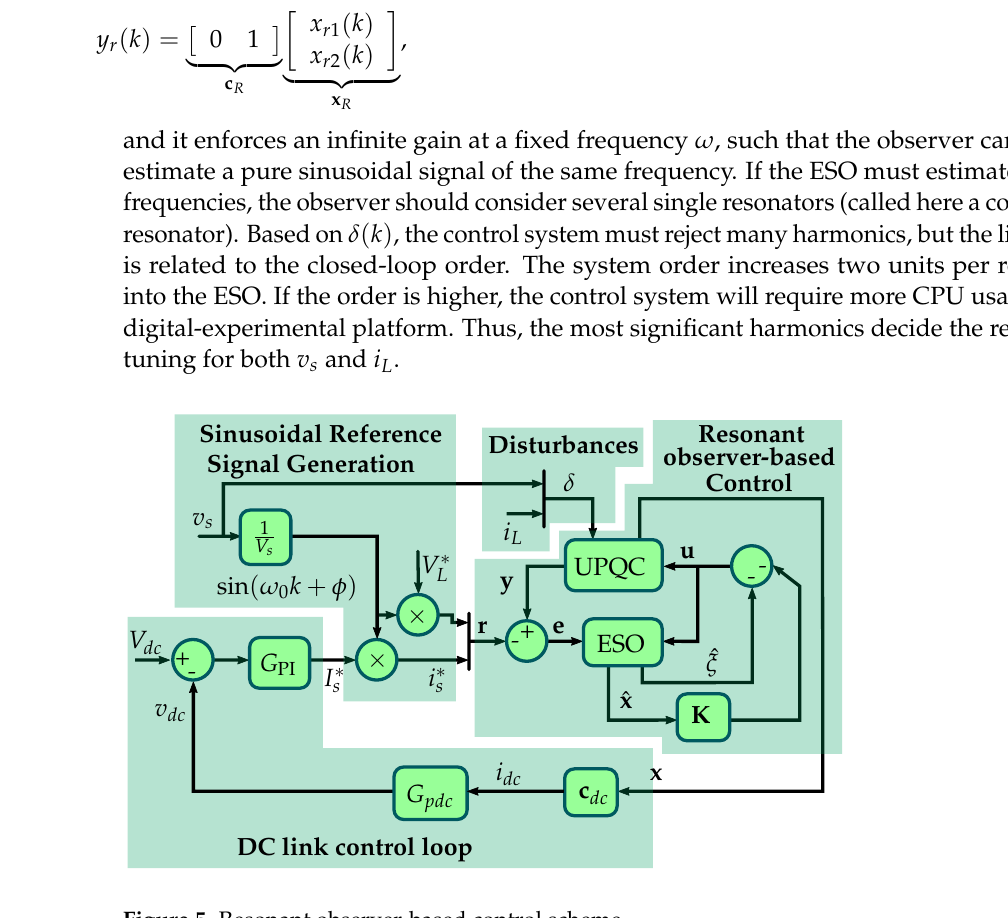
Figure 5. Resonant observer-based control